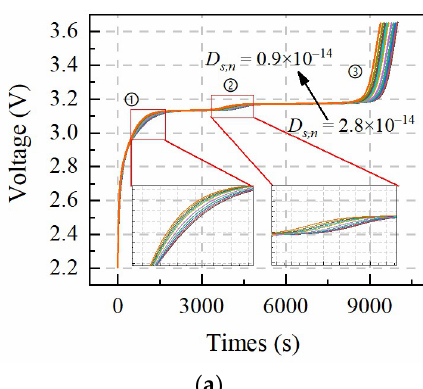
Figure 3. Sensitivity curves of battery terminal voltage to D s,n under different charging rates. ( a ) Sensitivity curves under 0.5 C charging rate; ( b ) Sensitivity curves under 1 C charging rate.